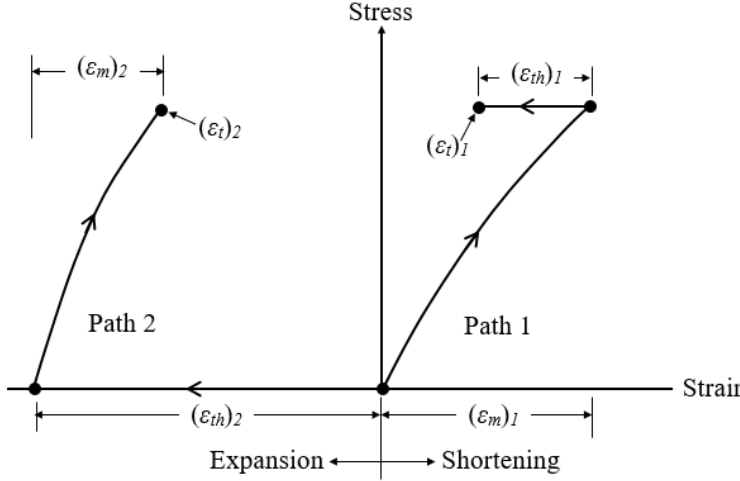
Figure 1. Influence of temperature–stress interaction on the concrete strains.